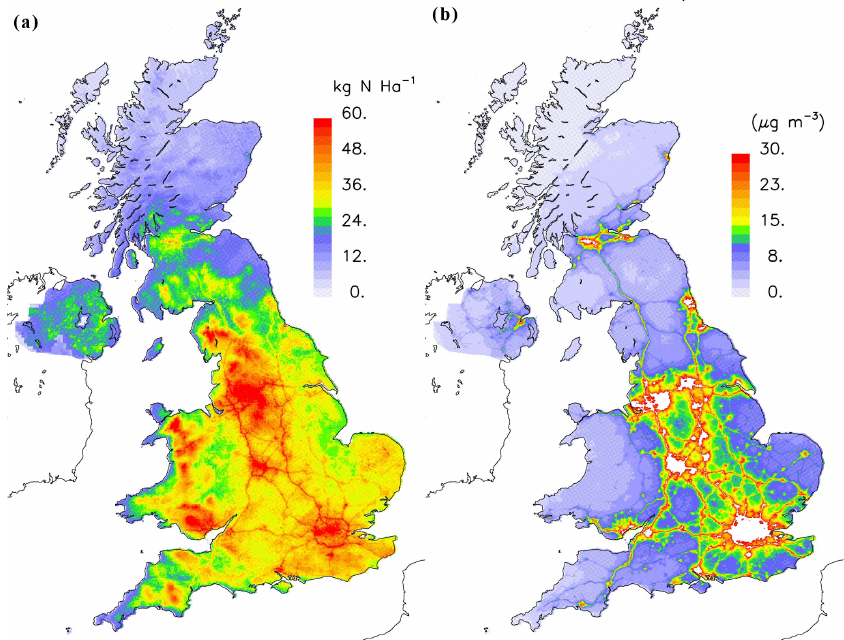
Fig. 2. (a) Total nitrogen deposition in the UK (left). (b) NO x concentration in air (right) for the year 2007 calculated with the FRAME model at a 1km resolution. NO x concentrations above the 30µgm − 3 critical level are shown in